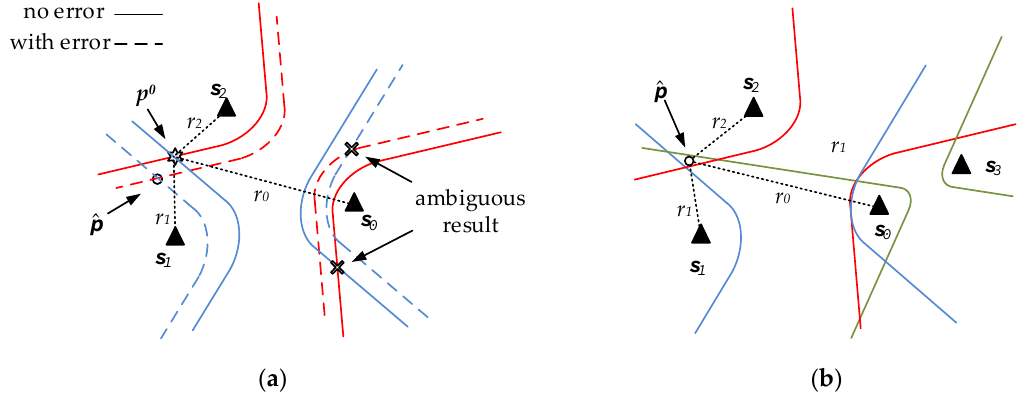
Figure 1. 2D hyperbolic localization (each color represents a couple of hyperbolas); ( a ) difference between ideal condition and reality; ( b ) multiple hyperbolas for the optimal position.